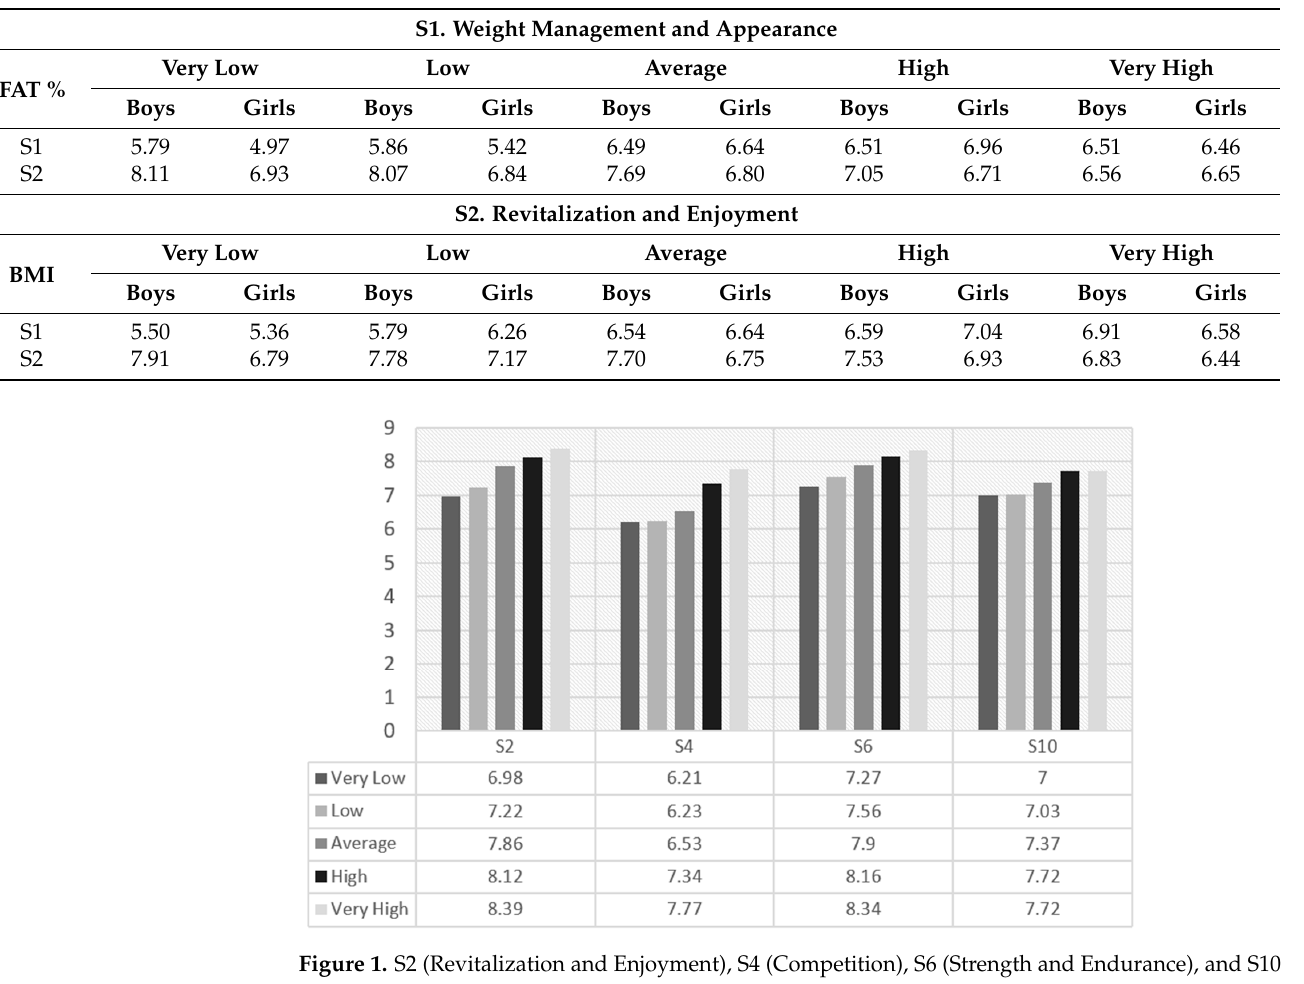
Table 4. S1 (Weight Management and Appearance) and S2 (Revitalization and Enjoyment) subscales scored by FAT % and BMI.